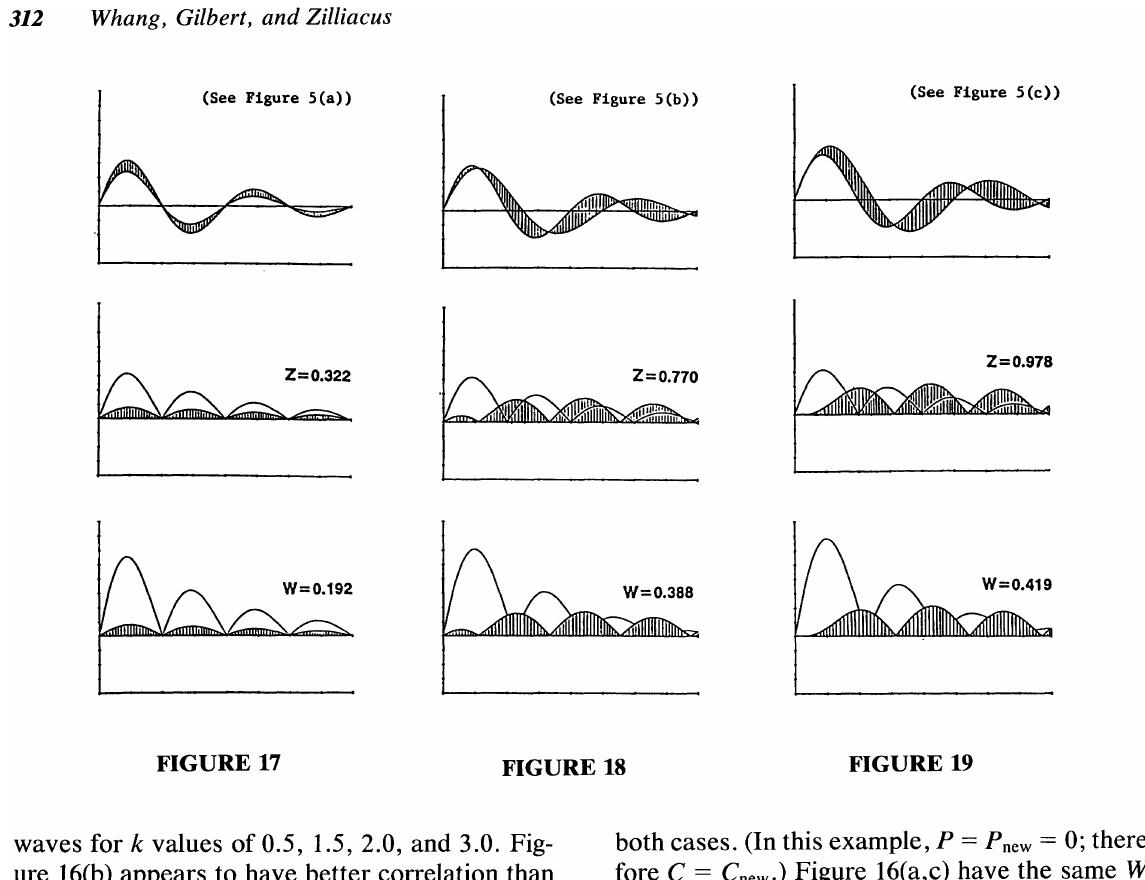
waves for k values of 0.5, 1.5,2.0, and 3.0. Fig ure 16(b) appears to have better correlation than Fig. 16(a), even though they both differ from the measured by 50% as shown by C = Z = 0.500 in